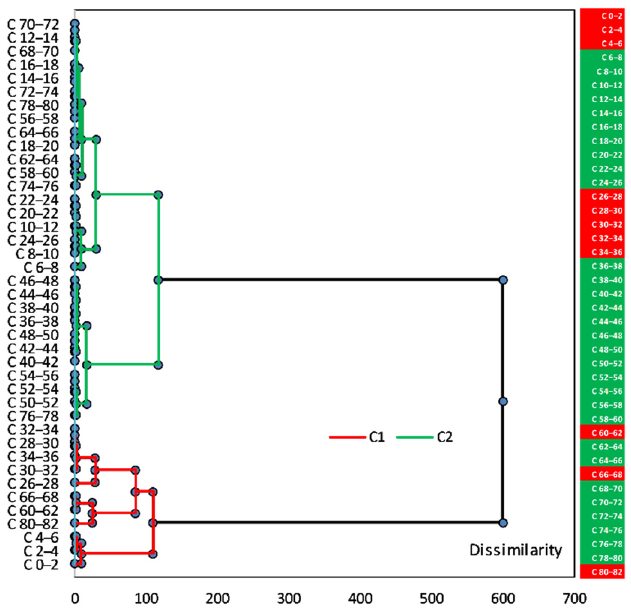
Figure 25. Dendrogram showing the clustering and vertical distribution (on depth) for the sediment sections of Caineni Lake.